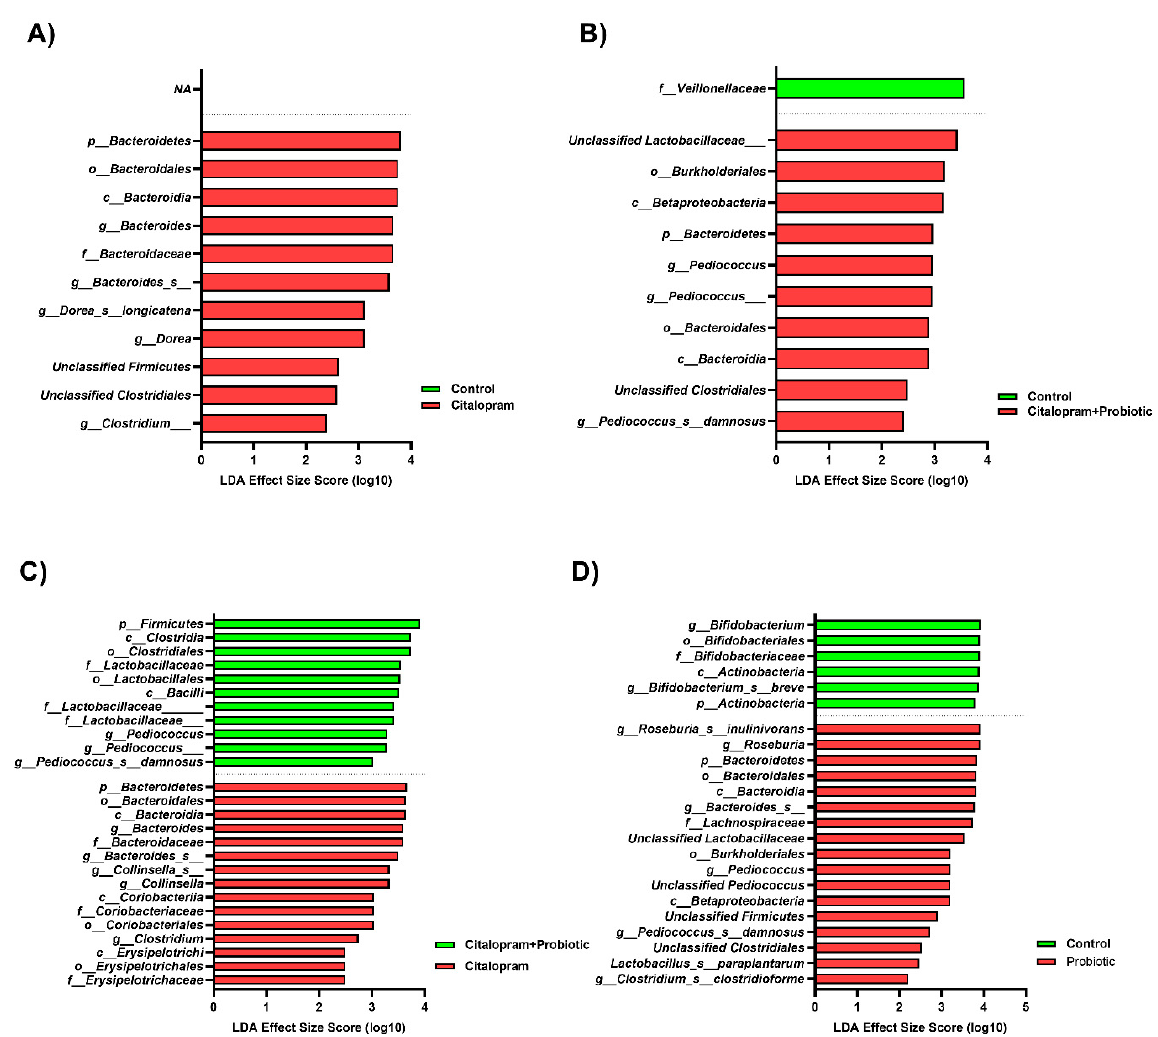
Figure 5. Histograms of the linear discriminant analysis (LDA) scores showing microbial taxa that vary significantly in abundance between: ( A ) no-treatment control and (S)-citalopram treatment, ( B ) no-treatment control and (S)-citalopram + probiotic treatment, ( C ) (S)-citalopram and (S)-citalopram + probiotic treatments, ( D ) no-treatment control and probiotic treatment.